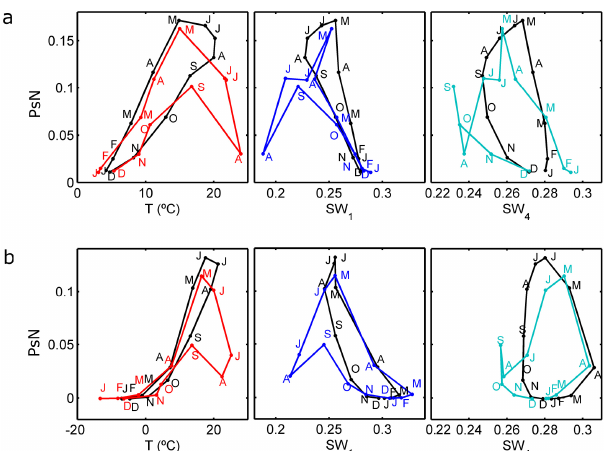
Figure 9. Climatological seasonal cycle (black lines) and sea- sonal cycle on the heatwave year (coloured lines) of ( xx axis) T (left panel, red lines), SW1 (central panel, blue lines) and SW4 (right panel, cyan lines) from ERA-Interim versus PsN ( yy axis) in kgCm − 2 month − 1 for (a) HW03, heatwave year 2003 and (b) HW10, heatwave year